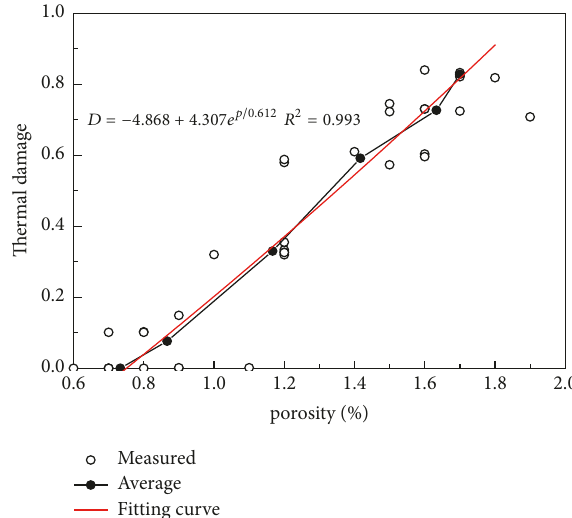
Figure 8: Relation of thermal damage and porosity.